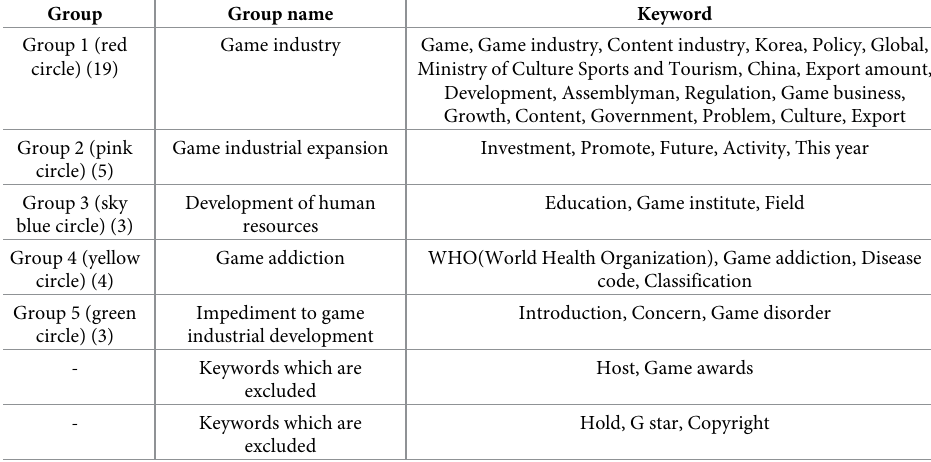
Table 3. Keyword groups based on CONCOR analysis in 2019.